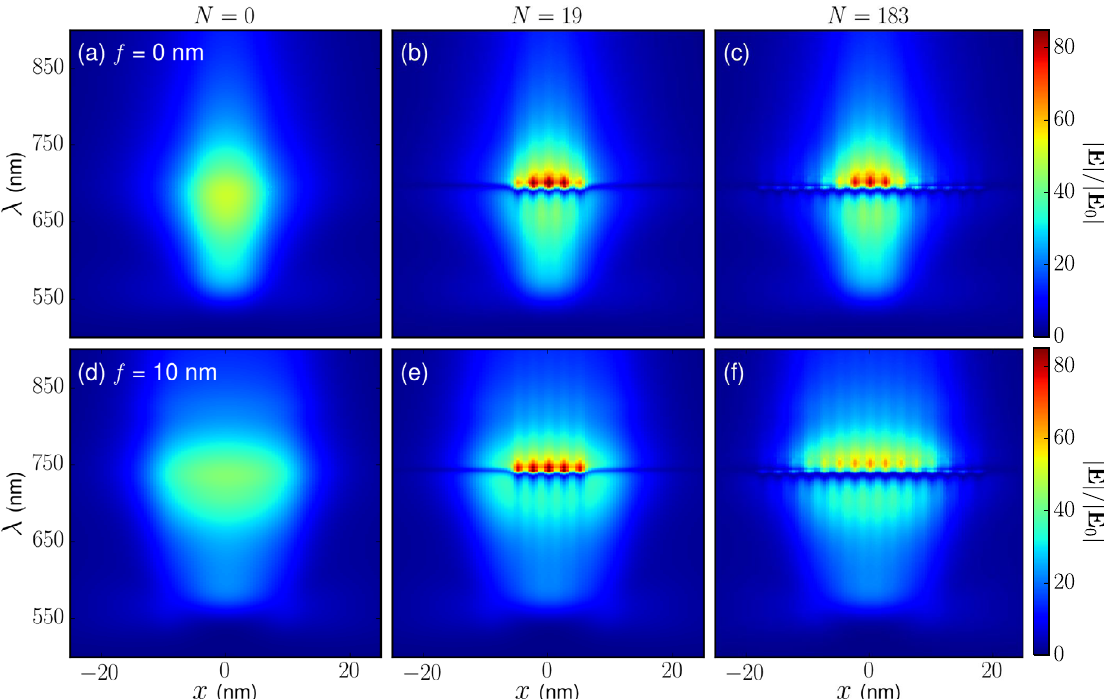
Fig. 4. Spatio-spectral fi eld distributions | E ( x , l )| of the emitter-plasmon hybrid states for (a,d) N =0, (b,e) N = 19, (c,f) N = 183 quantum emitters and (a,b,c) f = 0nm and (d,e,f) f =10 nm. The fi eld distributions are evaluated at 1 nm above the